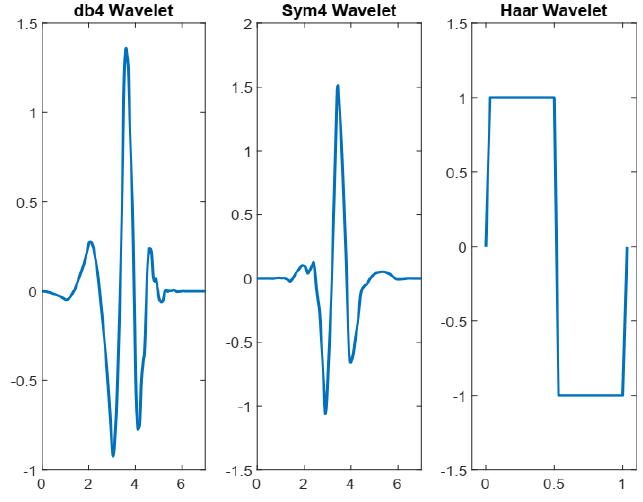
Figure 6. Characteristic signals of three mother wavelets.